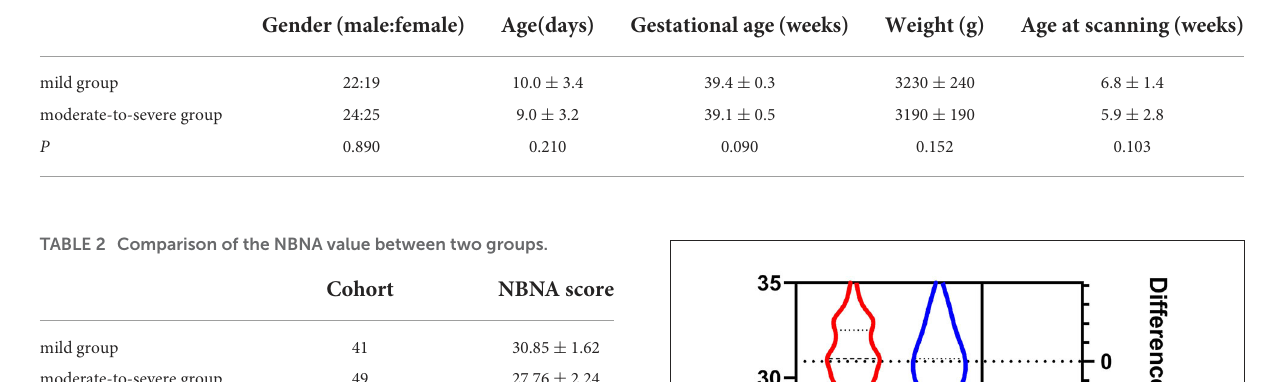
TABLE 1 Demographic variables of enrolled patients.